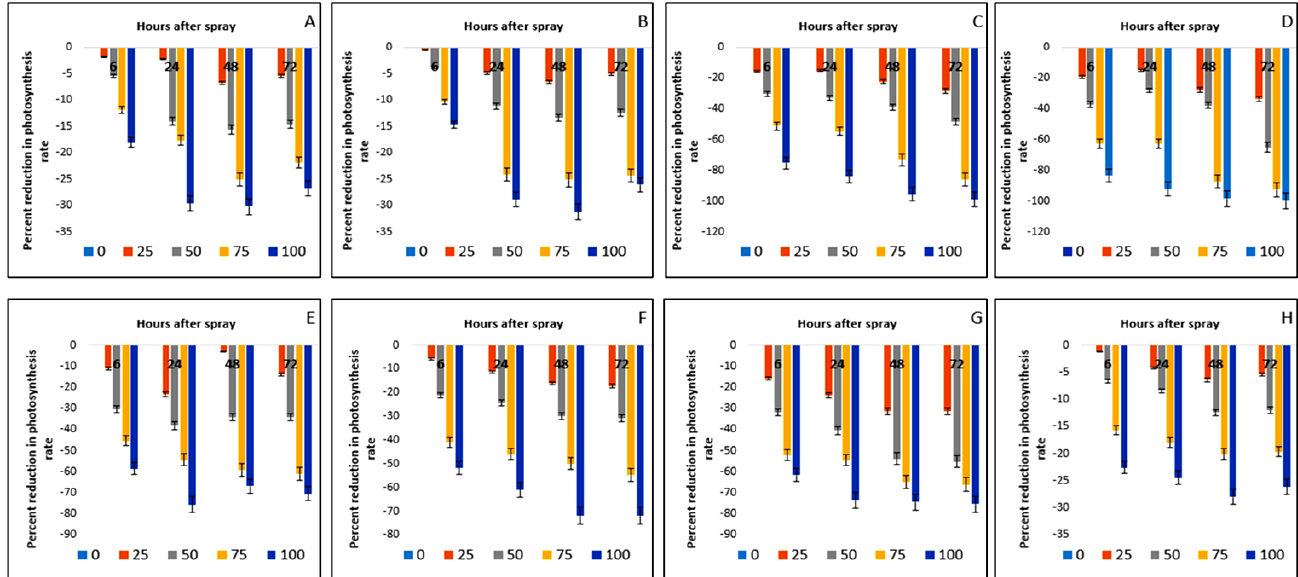
Figure 8. Reduction (%) of photosynthesis rate of several crops and weeds due to the effect of parthenium leaf methanol extract: ( A )—Bambara groundnut; ( B )—Maize; ( C )— D. sanguinalis ; ( D )— E. indica ; ( E )— A. conyzoides ; ( F )— C. iria ; ( G )— E. hirta , and ( H )— C. difformis .